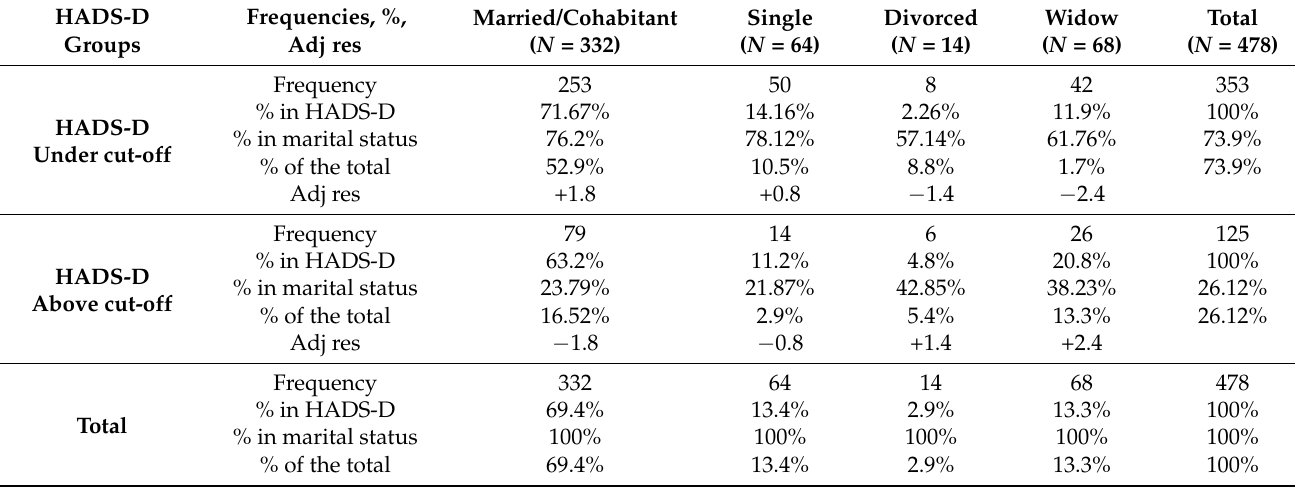
Table 3. Contingency table with frequencies of patients above/under the HADS-D cut-off scores and the marital status. HADS-D Groups